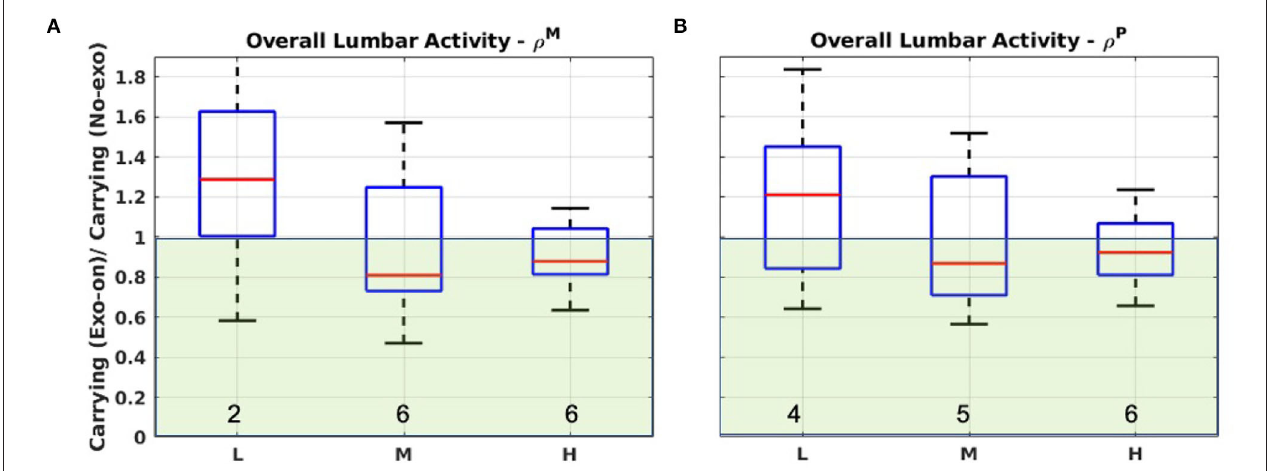
FIGURE 4 | Boxplot representations for ρ M and ρ P considering the overall lumbar muscle activity performing carrying in the No-exo condition and in the Exo-on one. (A) The 50th percentile of muscle activation ( ρ M ). (B) The 90th percentile ( ρ P ). L, M, and H refer to the light, medium, or heavy loading condition. Green-shaded areas identify the regions where ρ x i < 1 (i.e., the exoskeleton reduces the muscle activity). Note that in (A) the top whisker for the light loading condition extends up to 2.3. Numeric values at the bottom of each box report the value of γ